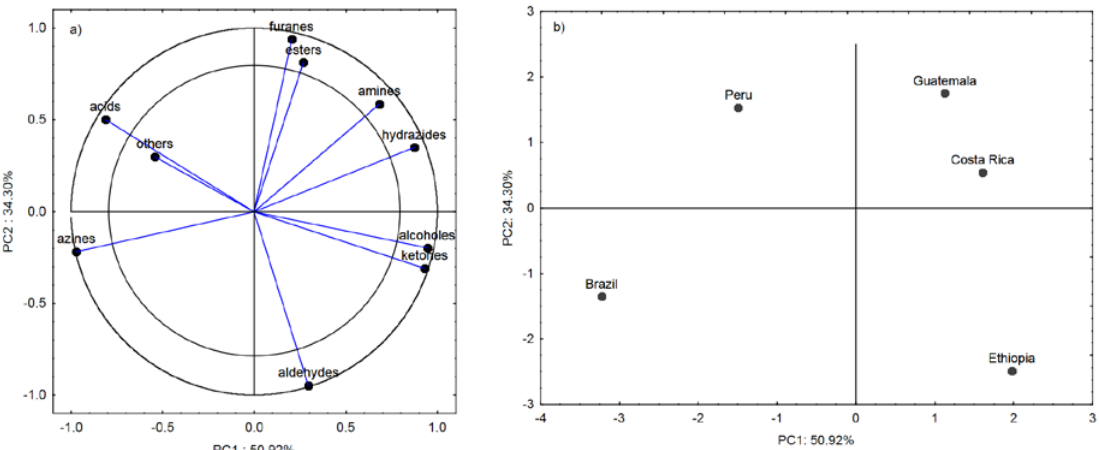
Figure 4. Loading plot ( a ) and score plot ( b ) of the principal components analysis carried out for ten chemical groups detected in all co ff ees from Brazil, Ethiopia, Guatemala, Costa Rica, and Peru. The chemometric analysis indicates that the co ff ee species maintain their specific odor profile, which is usually determined by four dominant groups of volatile compounds